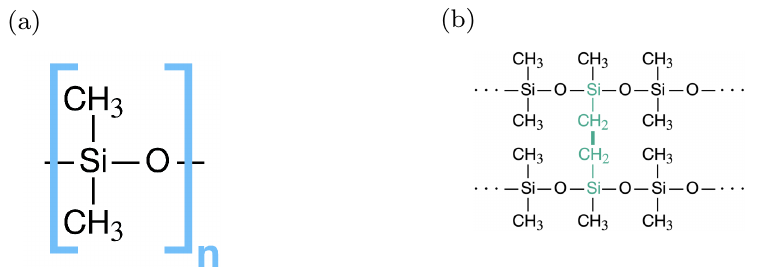
Figure 1. ( a ) Monomer unit of silicone; ( b ) crosslink bridge between silicone